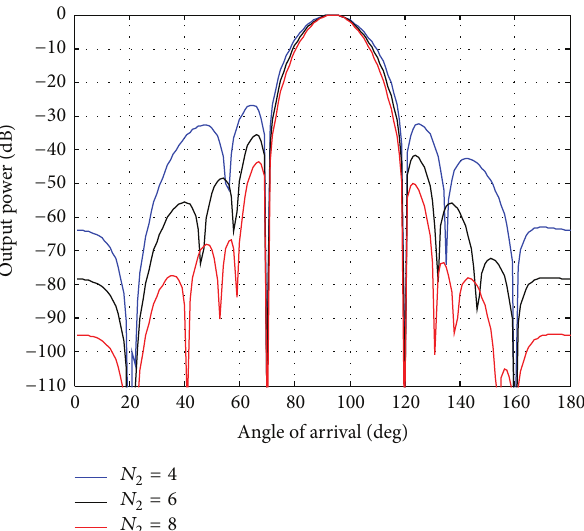
Figure 6: Performance of proposed algorithm for 𝑁 2 = 4 , 𝑁 2 = 6 , and 𝑁 2 = 8